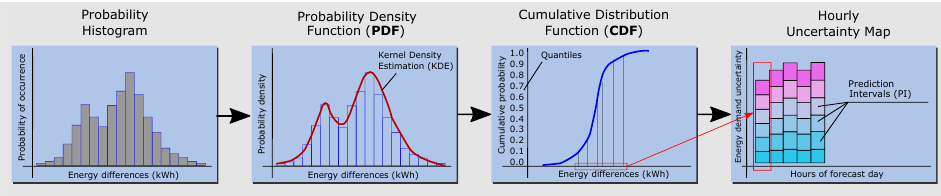
Figure 3. Process of the probabilistic load forecast